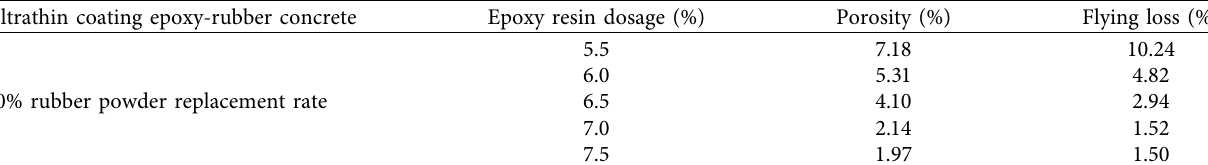
Table 4: Fort Kentucky test results for concrete with different epoxy resin